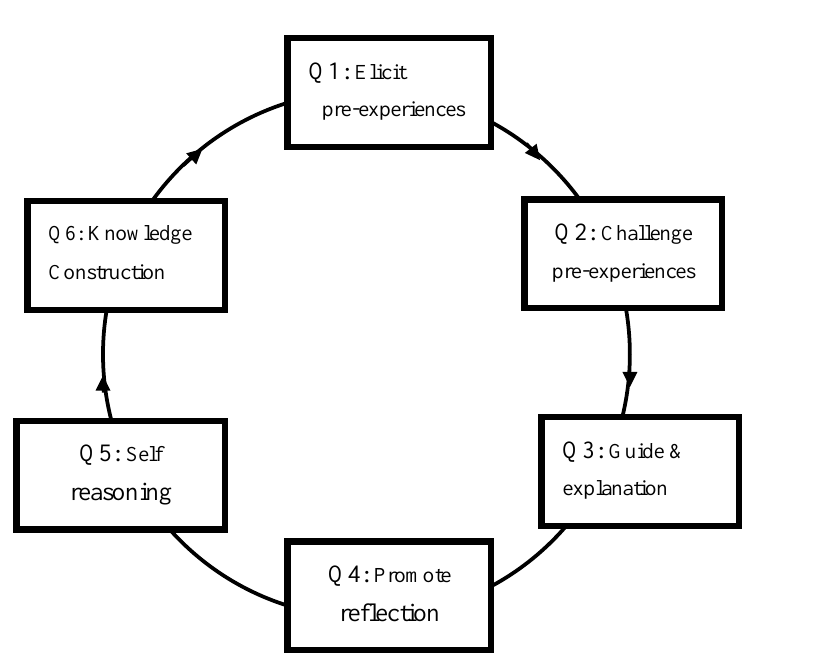
Figure 1 . The design of a question